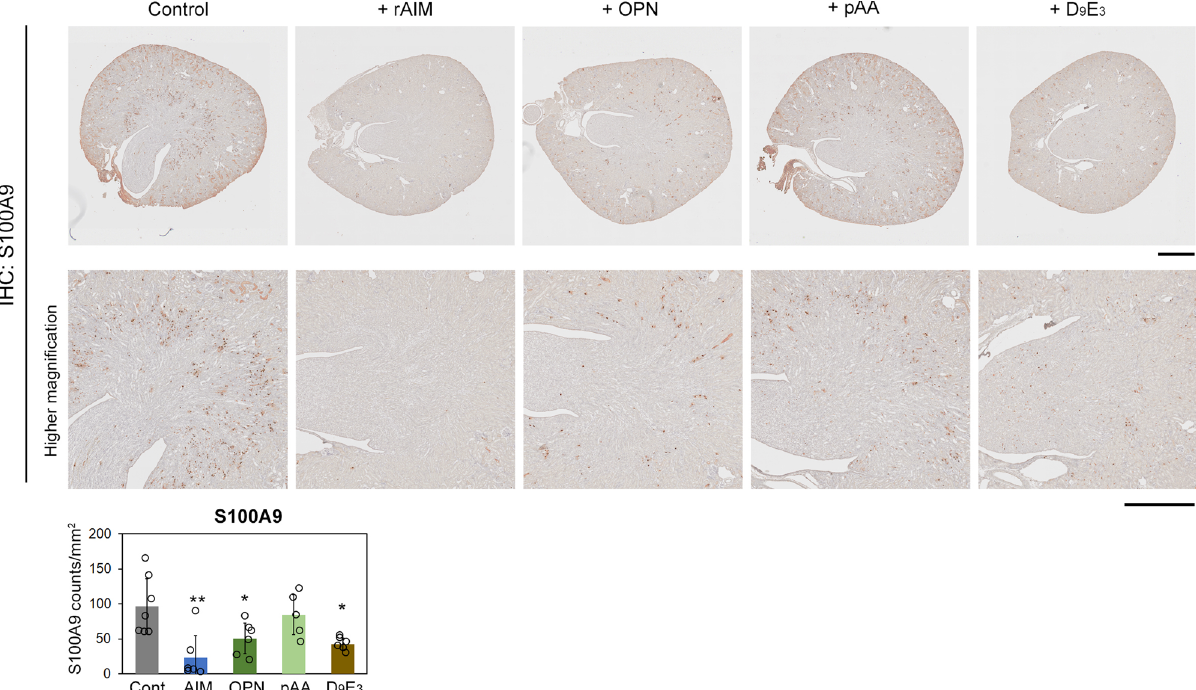
Fig. 5 Removal of DAMPs in the kidney by rAIM. Immunohistochemistry for S100A9 in kidney specimens from mice at day 6 of glyoxylate loading. Before analysis, the mice were injected with either rAIM, rOPN, pAA 5.1 , D 9 E 3 peptide, R 8 K 4 peptide (amounts were as in Fig. 3b), or PBS at identical molar levels. Extracellular S100A9 positive area was analyzed. 7 control (PBS-injected) mice and 6 mice for other groups were analyzed. In pAA 5.1 injected mice, two circles are merged, and thus, one data point appears to be missing. Scare bars: 1 mm (for upper panels), 100 µ m (for lower panels). Means ± s.d. are shown. Statistical analysis was performed with one-way ANOVA followed by Dunnett ’ s post hoc test. Signi fi cance is added when there is a signi fi cant difference against the control.